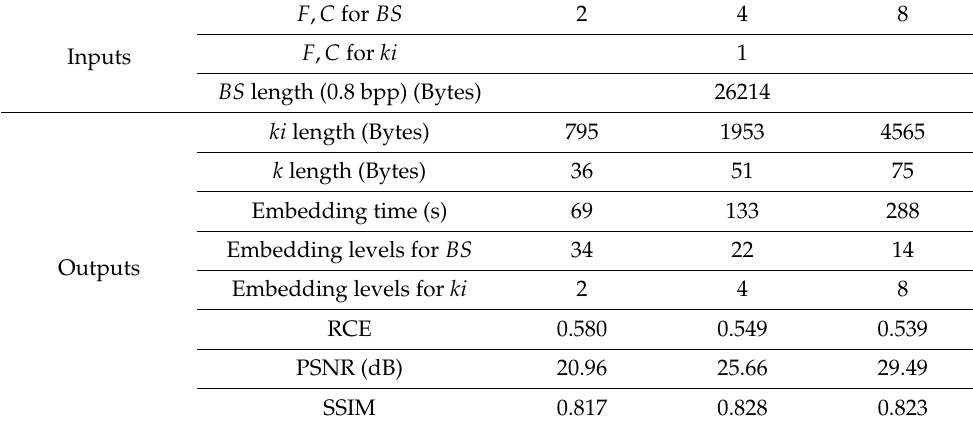
Table 3. Quantitative